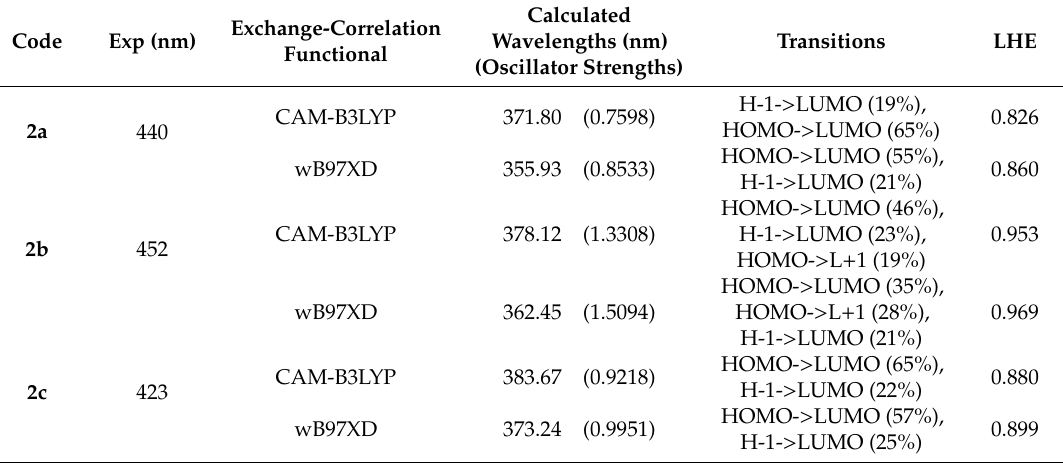
Table 5. Calculated by TD-DFT, the lowest energy absorption bands with oscillator strengths compared to experimental data, values of light-harvesting e ffi ciency (LHE) for 2a–2c. Calculated Exchange-Correlation Wavelengths (nm) Transitions LHE Code Exp (nm) Functional (Oscillator Strengths) 440